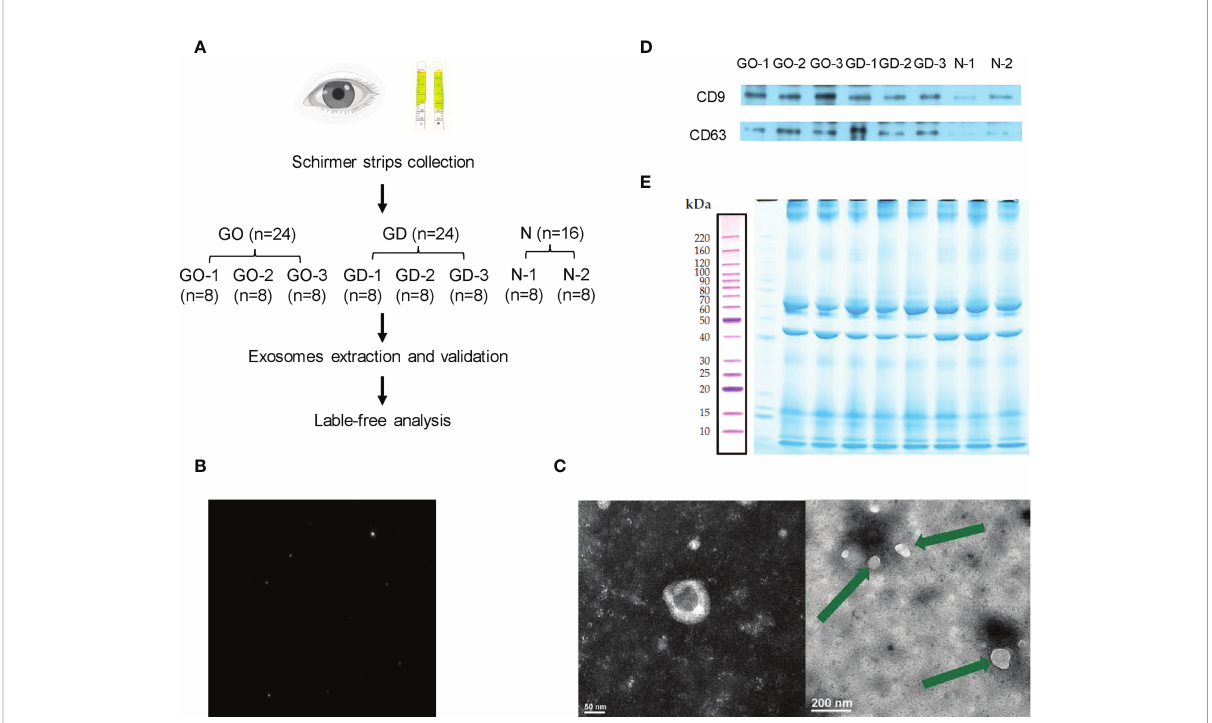
FIGURE 1 Work fl ow and preparation before LC − MS/MS analysis. (A) Experimental work fl ow of this study. (B) Representative nanoparticle tracking analysis of tear exosomes. (C) Representative transmission electron microscopy images of tear exosomes. The scale bar on the left represents 50 nm, and the scale bar on the right represents 200 nm. (D) Expression of CD9 and CD63 in exosomes of active GO patients, GD patients and healthy controls. (E) Exosomal protein presented in SDS-PAGE with Coomassie Brilliant